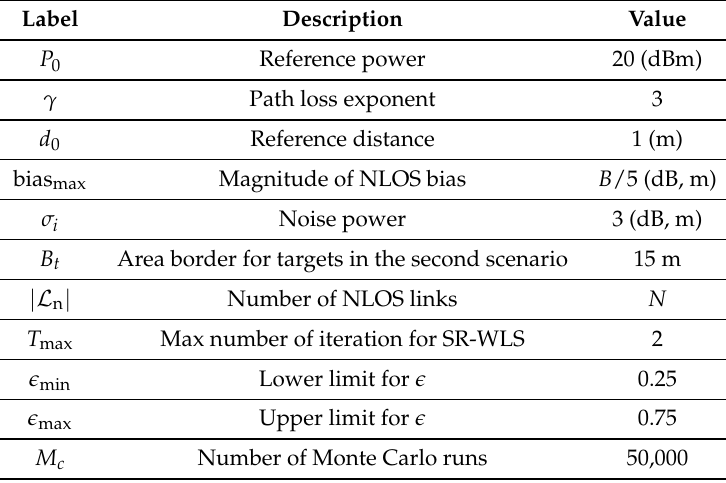
Table 3. Summary of the Fixed Simulation